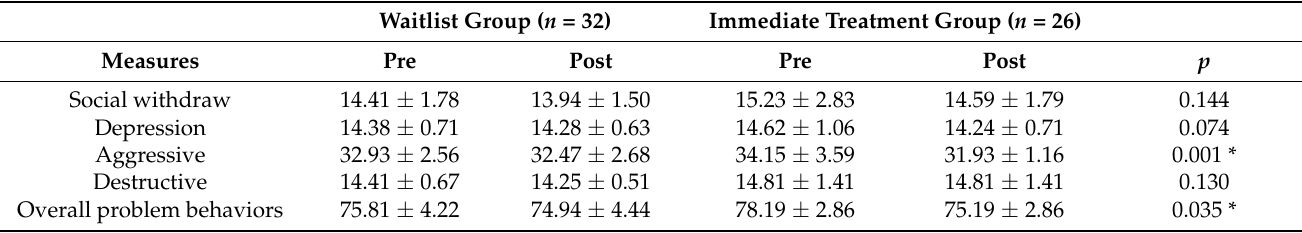
Table 2. Means for children’s problem behavior and between-group difference in